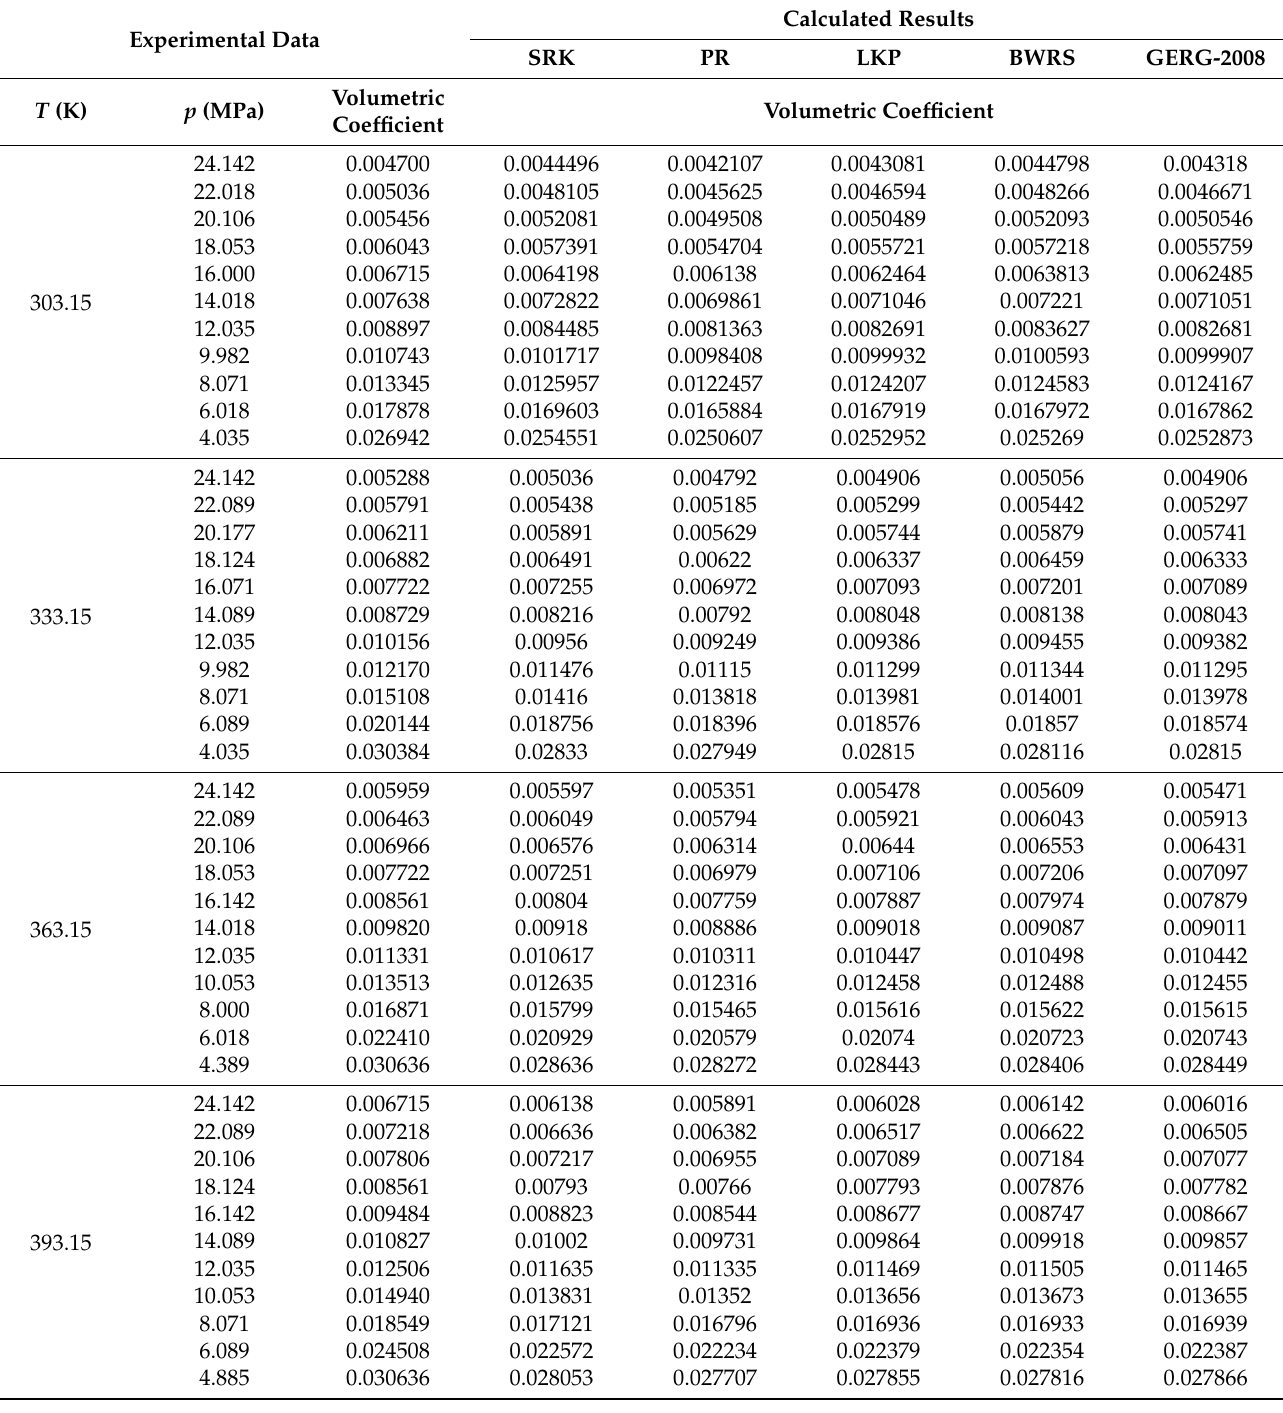
Table 8. Experimental data and calculated results of the volumetric coefficient for Sample